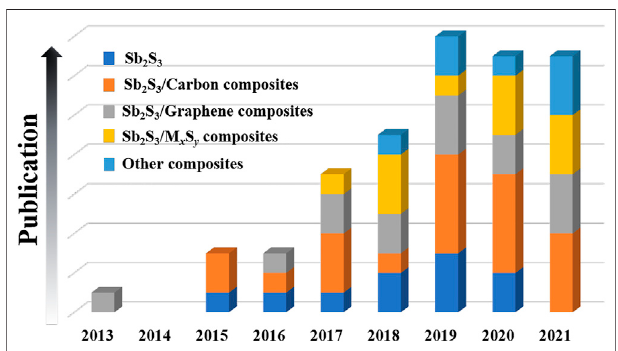
FIGURE1| BarchartofSb 2 S 3 -basednanomaterialsasanodesforSIBs in recent years.